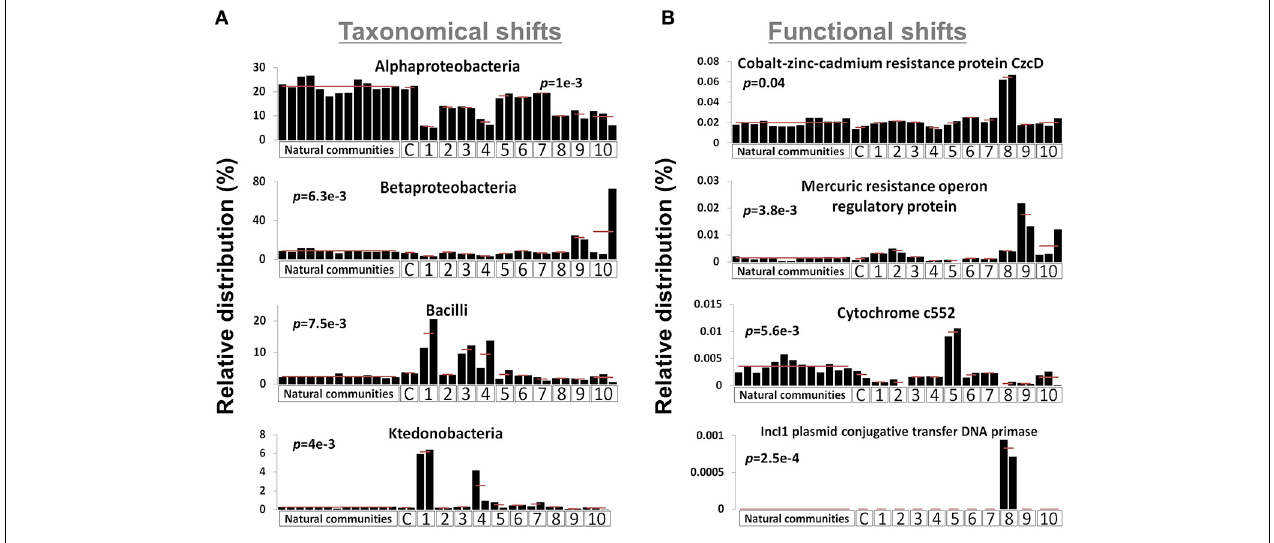
FIGURE 1 | Graphs represent the relative distribution of 4 bacterial taxa using M5NR databases (A) and Pfams (B) in the 36 metagenomic datasets when annotated in MG-RAST. E -value cut-off was defined as 10-5. P -values were defined using distribution